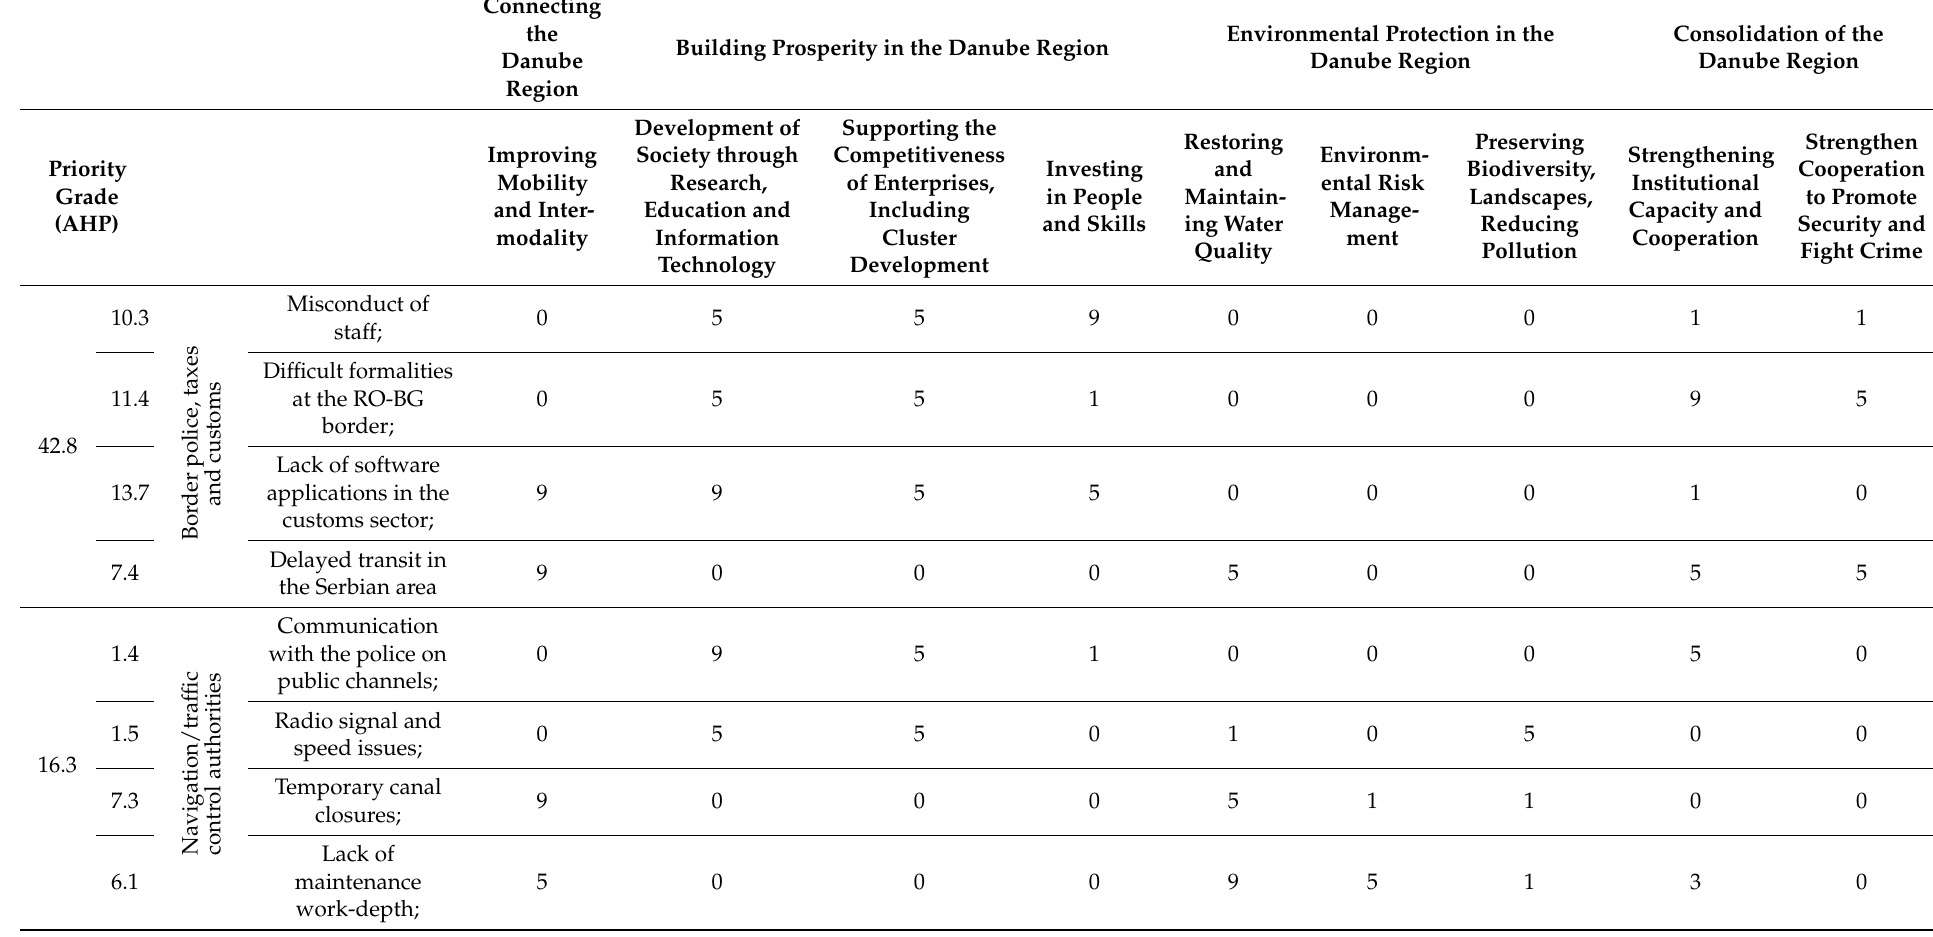
Table A2. Relationship between Administrative Barriers in the Navigation Sector on the Danube and the Action Pillars Proposed by the European